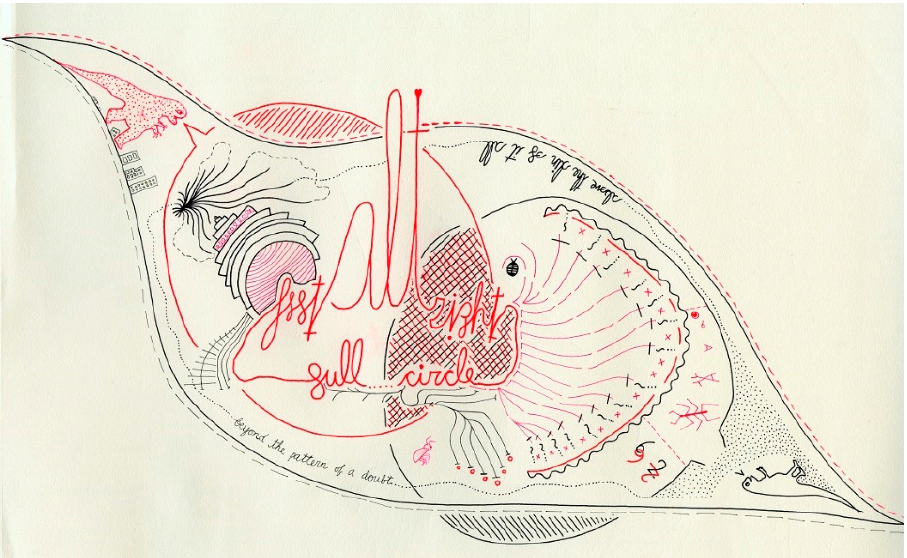
Figure A4. “Full Circle”. A literal conversation on paper. Red and black pens, white paper. Drawing